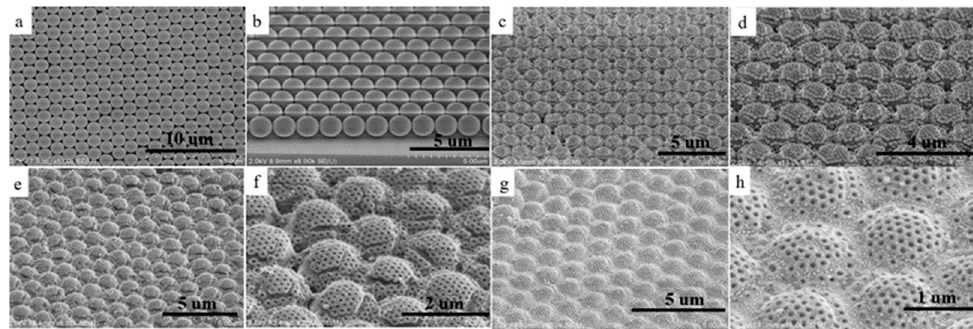
Figure 1. SEM images of the substrates. ( a , b ) 2D PS template; ( c , d ) 3D PS template; ( e , f ) 3D-TiO 2 /Si; ( g , h ) Ag/3D-TiO 2 /Si.